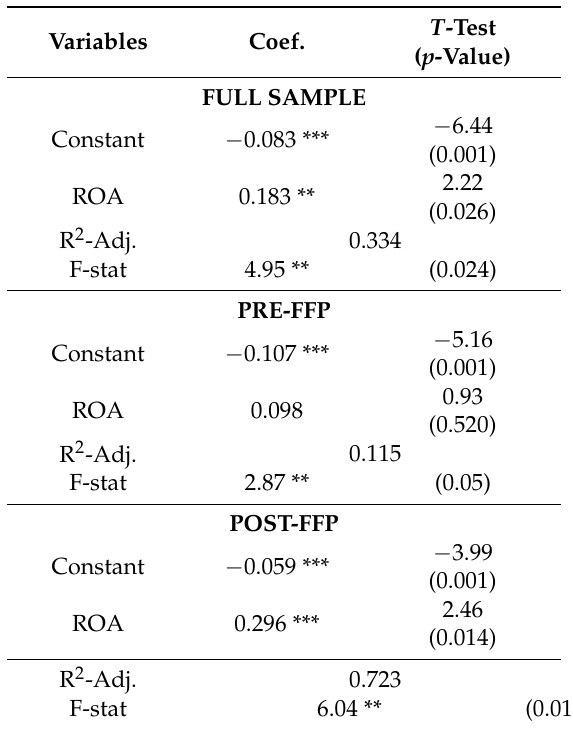
Table 3. Earnings persistence